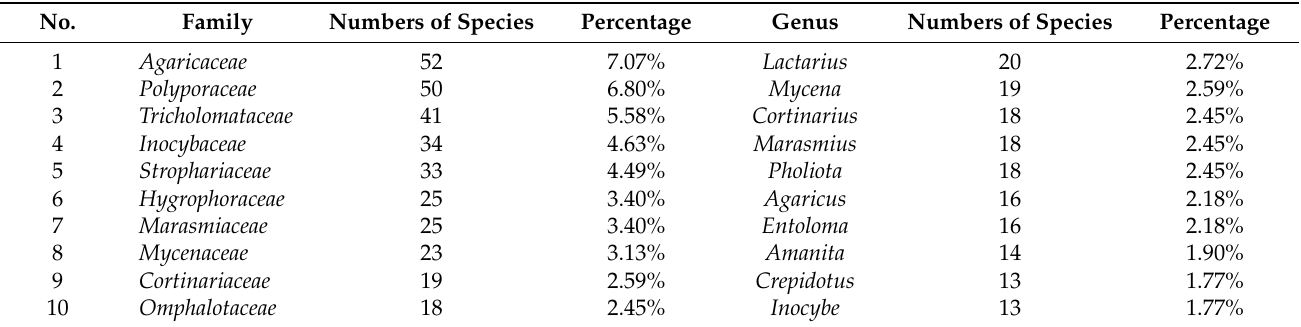
Figure 7. Diversity index analysis at genus level in six different investigation sites from Jilin Province. ( A ) Simpson diversity analysis in six different investigation sites from Jilin Province; the Simpson diversity index revealed site B2 was higher than the other five sites. ( B ) Shannon–Wiener diversity analysis in six different investigation sites from Jilin Province; the Shannon–Wiener diversity analysis showed site B2 was higher than the other five investigation sites. This result indicated that site B2 had the richest species diversity at the genus level and the most uniform distribution of species quantity. A1: Quanshuidong Forest Farm; A2: Lushuihe National Forest Park; B1: Shengli River Forest Farm; B2: Longwan National Forest Park; C1: Zuojia Region; C2: Jingyuetan National Forest Park. Table 4. Top 10 families and genera in six different investigation sites from Jilin